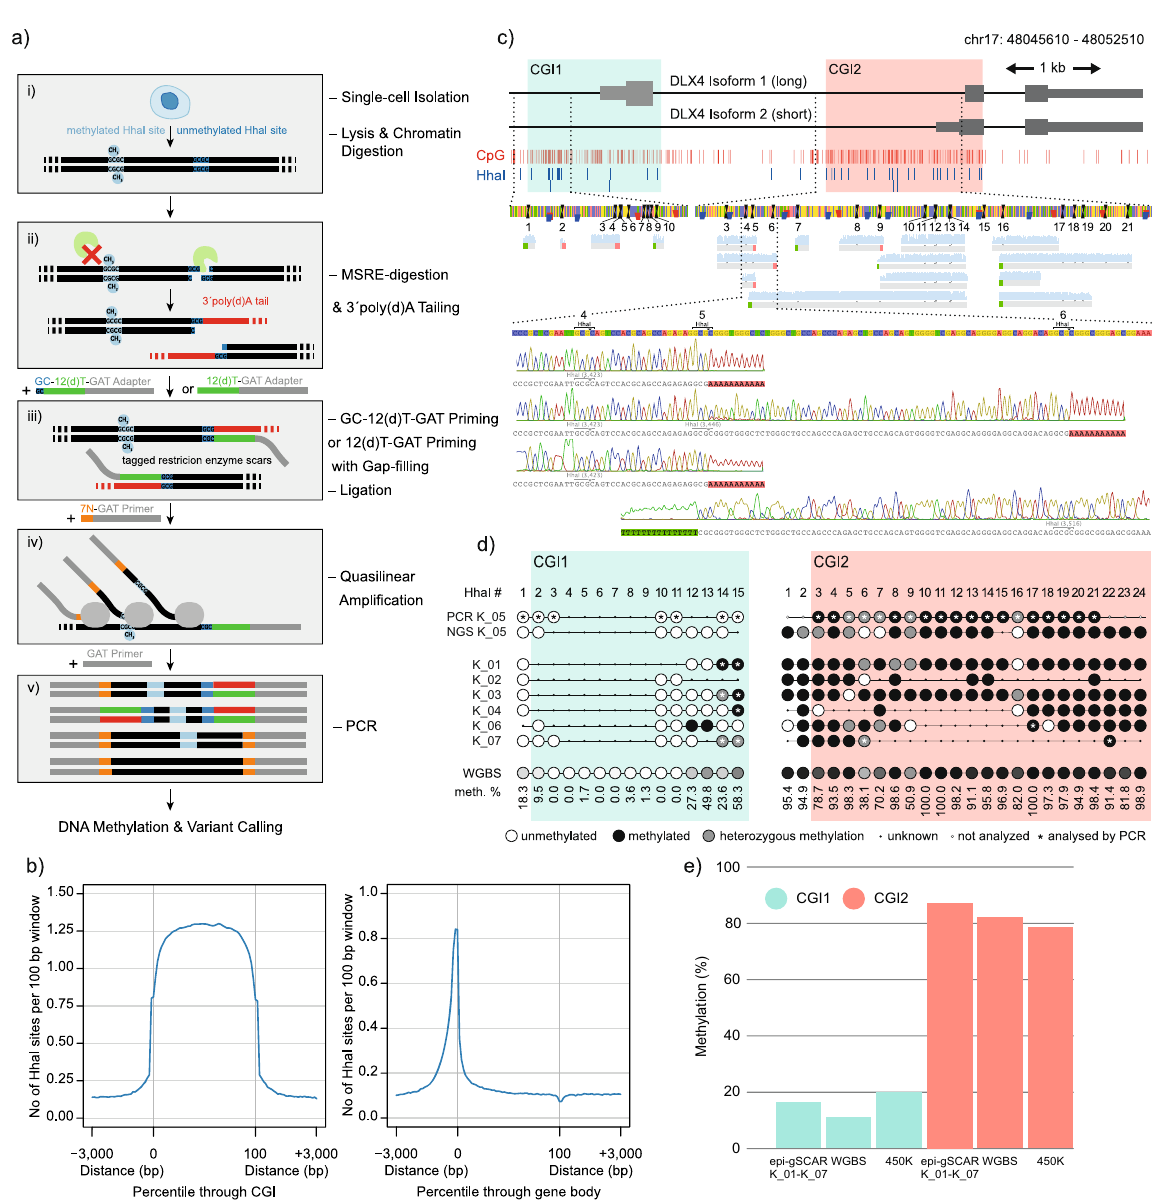
Fig. 1 epi-gSCAR work fl ow schematics and methylation readout for the DLX4 locus. a epi-gSCAR work fl ow: single-cell isolation is followed by lysis and chromatin digestion to render DNA accessible for methylation-sensitive restriction enzyme (MSRE) digestion with HhaI (i). Cleavage of methylated HhaI sites (light blue) is blocked, while unmethylated sites (dark blue) are cleaved; the resulting DNA ends are tagged with poly(d)A tails (red) (ii). Poly(d)A tails are primed by anchored (GAT-oligo(dT)12-CG, blue – green – gray, assay variant A) or non-anchored adapters (GAT-oligo(dT)12, green – gray, assay variant B). Anchored adapters were used to limit the length of poly(d)A tails in the library (Supplementary Fig. 8). This is followed by gap fi lling and ligation, which results in tagged restriction enzyme scars (iii). Random priming by 7N-GAT adapters (orange – gray) facilitates quasilinear ampli fi cation of the genome (iv). PCR generates amplicons carrying genetic and epigenetic information (v). b HhaI sites in CGIs and around TSSs across 100 bp windows and 3 kb upstream and downstream. c Methylation analysis of the DLX4 locus by step-out PCR followed by Sanger sequencing. DLX4 locus with CGI1 (green) and CGI2 (red), CpGs (red) and HhaI sites (blue), primer map for analysis of HhaI sites 1 – 10 (CGI1) and 3 – 21 (CGI2), and corresponding sequencing reads. Magni fi cation of reads obtained from single cell K_05 (selected for analysis as it demonstrated satisfactory results in initial suppression PCR experiments) corresponding to HhaI sites 4 – 6 in CGI2 showing intact and tagged-scar HhaI sites: intact HhaI sites are called as having been methylated and poly(d)A-tailed HhaI scar sites unmethylated; presence of both suggests heterozygous methylation. d DNA methylation in single cells K_01 – K_07 at individual HhaI sites for CGI1 (green) and CGI2 (red) of DLX4 assessed by PCR and/or NGS (Supplementary Fig. 3), and comparison with Kasumi-1 cell-bulk whole-genome bisul fi te sequencing (WGBS) data. Using step-out PCR on single cell K_05, CGI1 was unmethylated at all analyzed HhaI sites (6/6). CGI2 featured high level of heterozygous methylation (14/19 methylated; 5/19 heterozygous methylation). e Mean methylation levels of CGI1 (green) and CGI2 (red) for single cells K_01 – K_07 (NGS and PCR), Kasumi-1 WGBS and Illumina 450 K